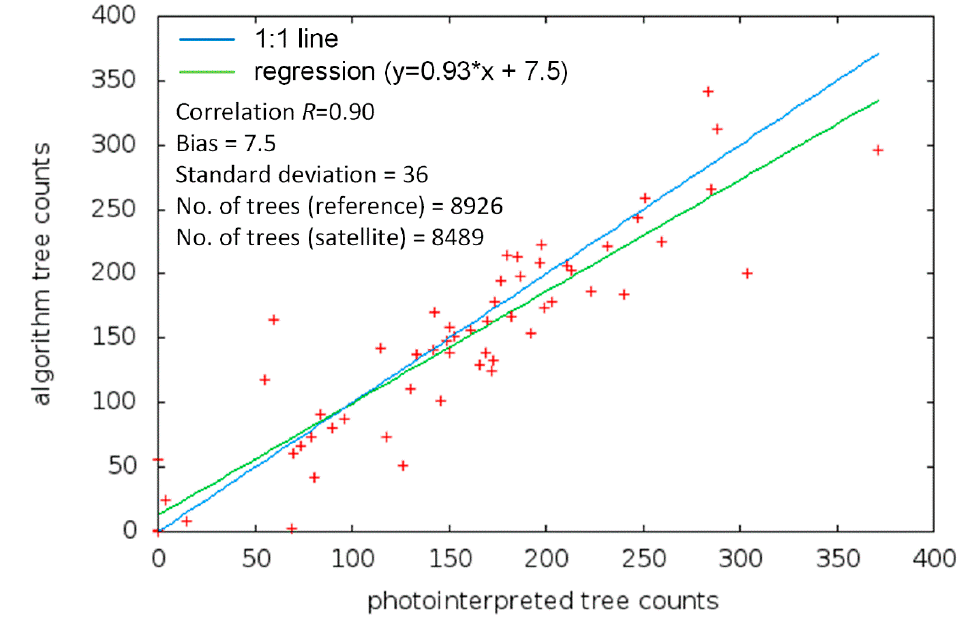
Figure 7. Results of the coconut tree counting algorithm validation for the Vaini region.